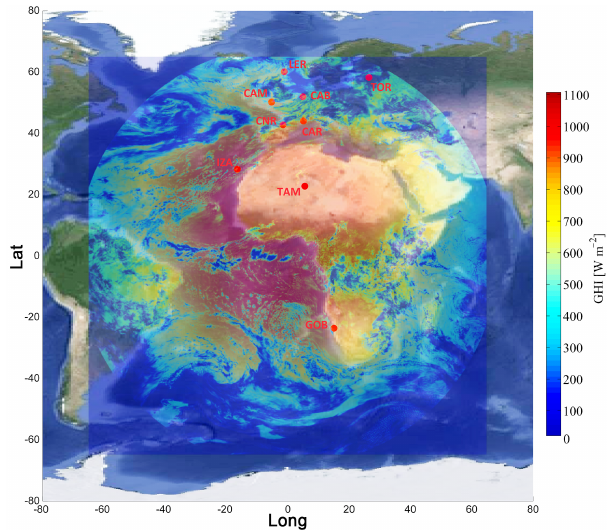
Figure 2. An example of the output maps based on the real-time SSR techniques. Here is the GHI for 15 April 2015 at 12:00UTC together with the BSRN station